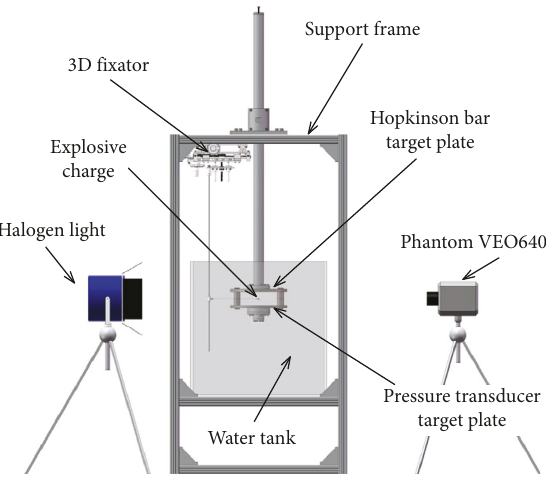
Figure 3: Schematic of the test system of